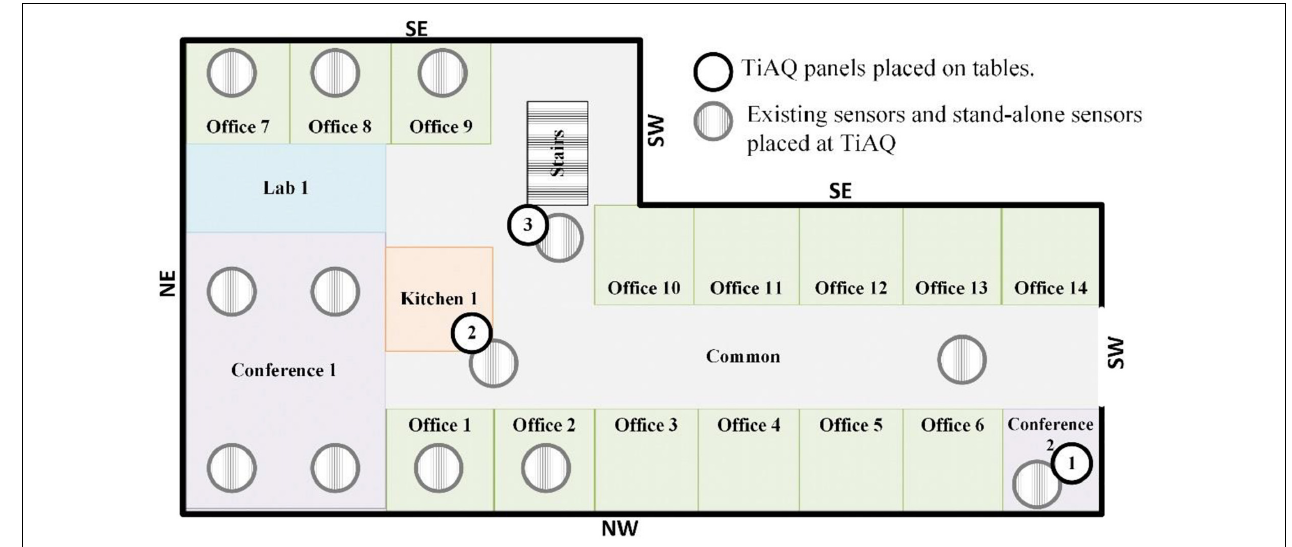
FIGURE 4 | Location of TiAQ, work areas and deployed sensors in the Intelligent Workplace at Carnegie Mellon University.